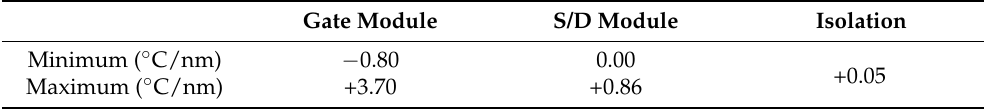
Table 4. Summary of temperature sensitivity according to dimensional and material engineering of the gate, S/D, and isolation module for the punch-through current-based local thermal annealing. Gate